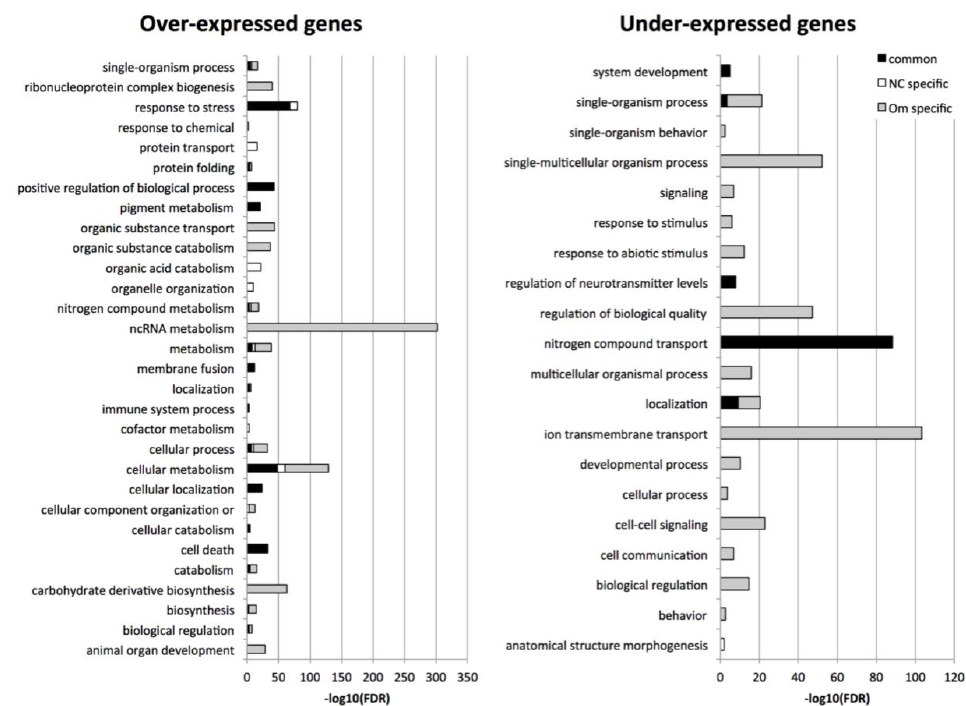
Figure 8 . Summary of the GO enrichment analysis following REVIGO synthesis. Each enriched biological process is represented by a bar proportional to the log10(FDR). The colors correspond to the three categories of genes (common: black; Om-specific: grey; NC-specific: white) that were over- expressed (left panel) or under-expressed (right